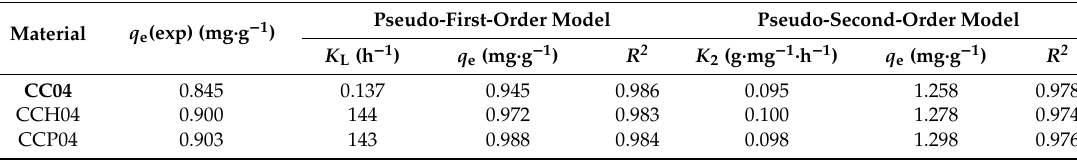
Table 4. Parameters for the kinetics models of the synthesized